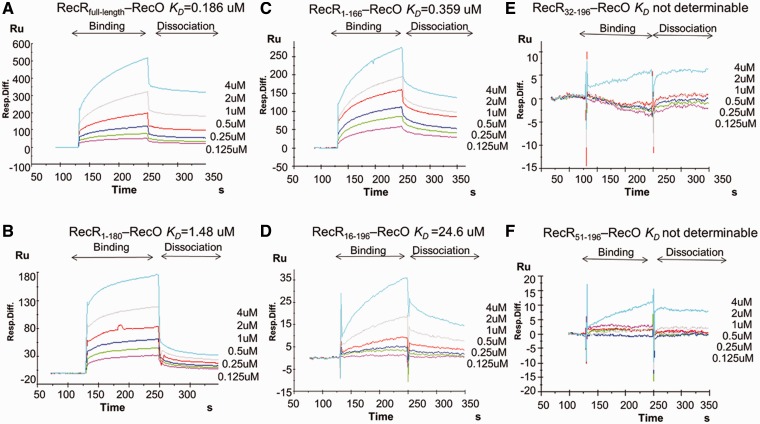
Contribution of the TTERecR N-N dimer to TTERecO binding. BIAcore biosensor analysis of full-length TTERecR (A); TTERecR1-180 (B); TTERecR1-166 (C); TTERecR16-196 (D); TTERecR32-196 (E); TTERecR51-196 (F), binding to TTERecO at 25°C. Sensorgrams are shown for 0.125, 0.25, 0.5, 1, 2 and 4 µM TTERecR or TTERecR mutants injected over the TTERecO-coupled surface. The apparent KD values were calculated from the kinetic KD (M) = Kd/Ka.